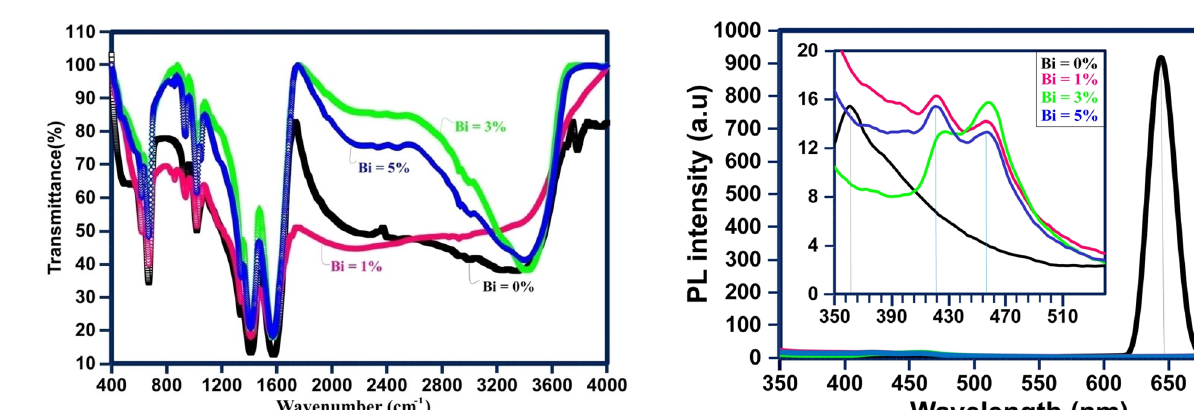
Table 2 IR peaks and their assignments of Cd QDs (x = 0% to 5%) at room temperature